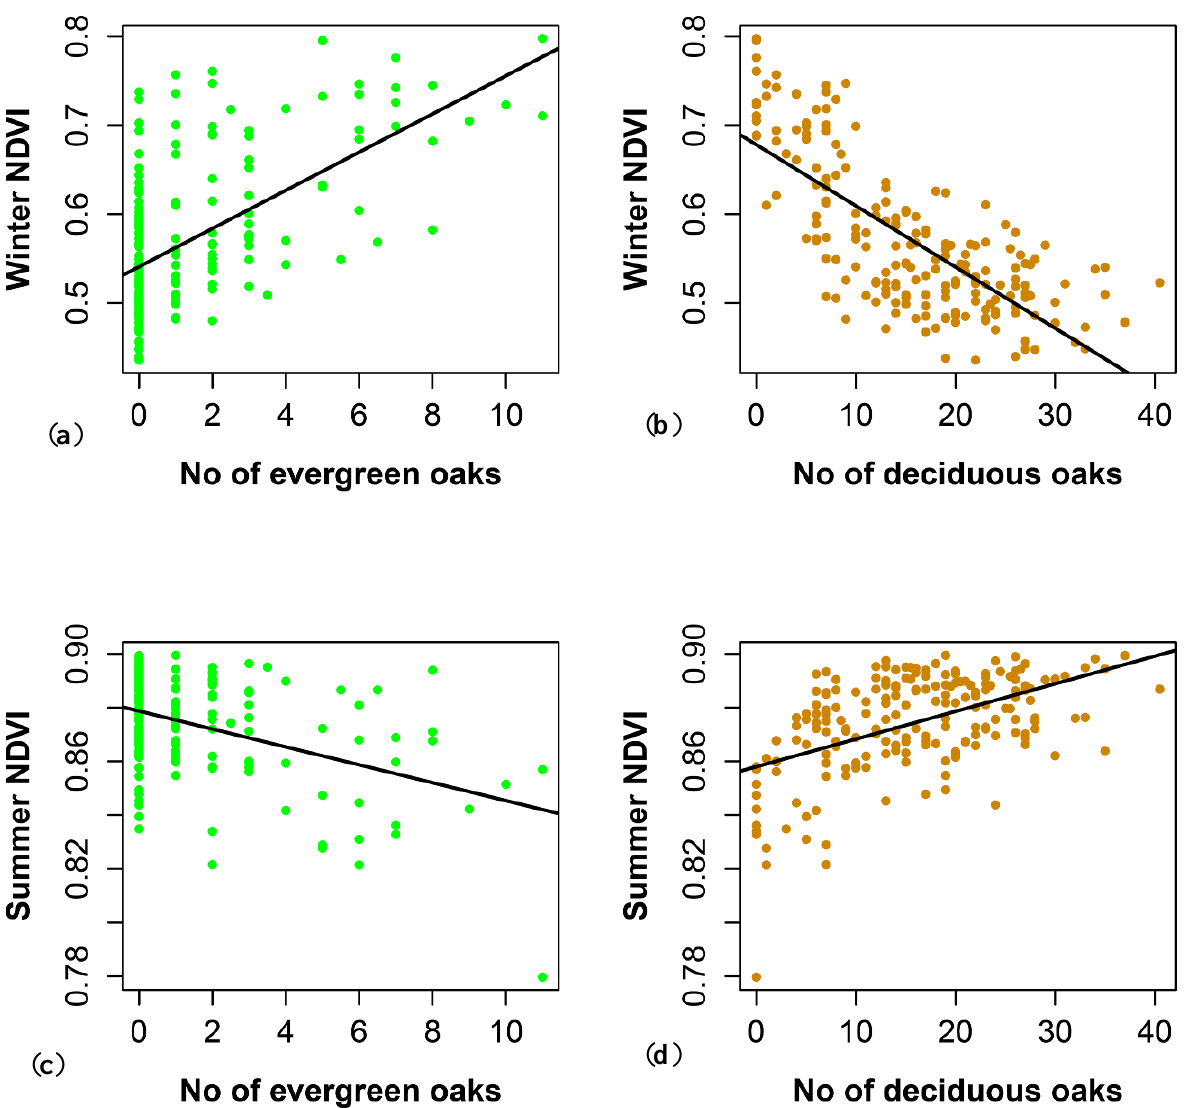
Figure 3. Regression of the number of evergreen and deciduous oaks on winter ( a , b ) and summer ( c , d ) NDVI values measured in a 50 m radius around each nestbox ( n = 194). Percentage of variance explained in each model: ( a ) 35%, ( b ) 54%, ( c ) 18%, and ( d ) 26% (more details in Tables